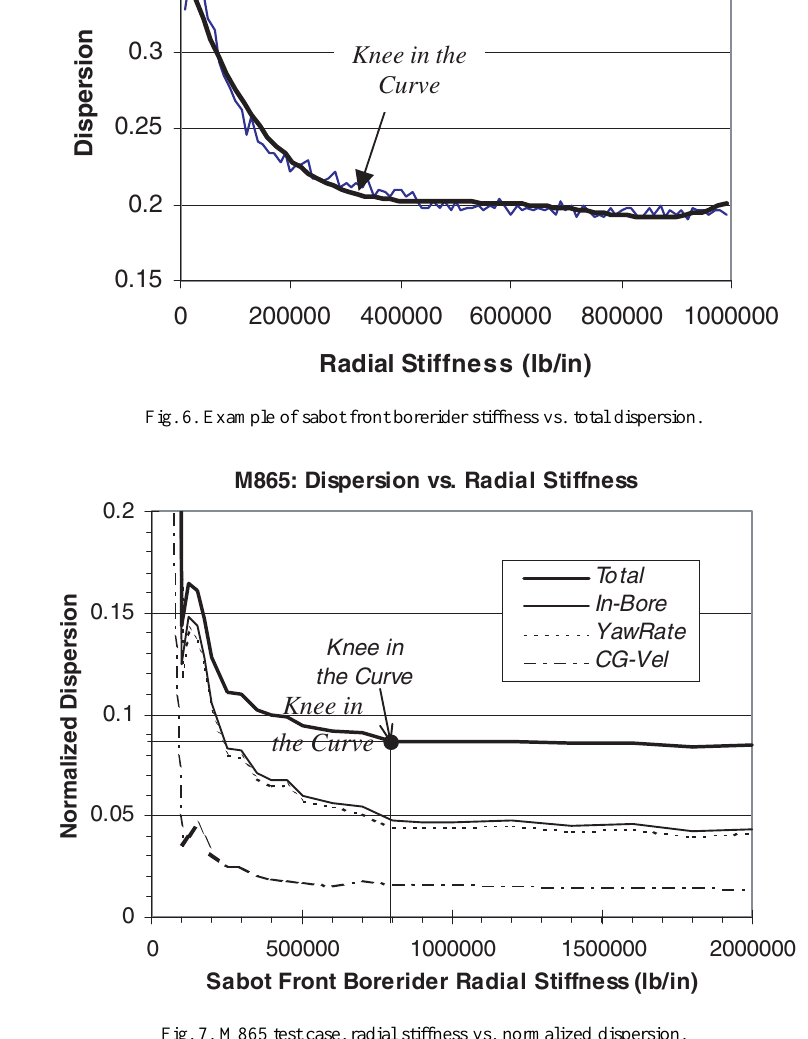
Fig. 7. M865 test case, radial stiffness vs. normalized